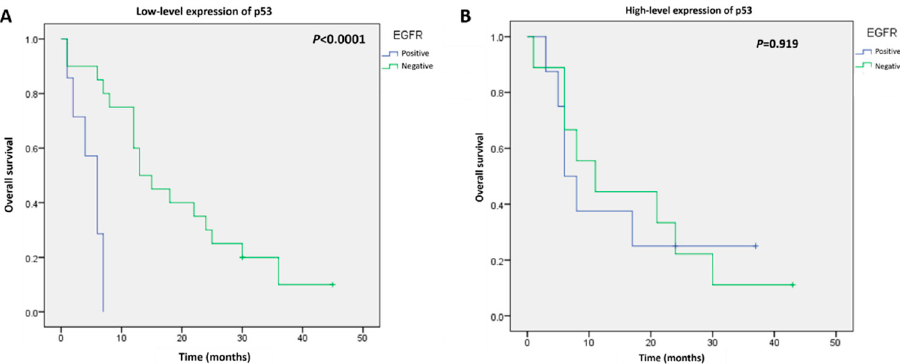
Figure 4. Kaplan–Meier analysis of overall survival in patients with EGFR-positive or EGFR-negative astrocytomas and ( A ) low-level expression of p53 or ( B ) high-level expression of p53. 3.4. Expression of p53, EGFR, and IC50s after Treatment with EGFR Inhibitors in GBM Cells Differences in p53 and EGFR protein expression in normal and cancer cells were deter- mined by Western blotting in glial cells (SVGp12) and GBM cells (GBM8041, GBM8901, U87-MG, G5T, and DBTRG-05MG). No significant differences in EGFR protein expression were detected in GBM8401, GBM8901, U87-MG, G5T, DBTRG-05MG, or SVGp12 cells (Figure 5). However, p53 protein levels were significantly lower in GBM8401, GBM8901, U87-MG, G5T, and DBTRG-05MG cells compared to the expression in SVGp12 cells (Fig- ure 5). In addition, p53 protein expression levels in GBM8401, GBM8901, and DBTRG- 05MG were significantly higher than expression levels in U87-MG and G5T cells (Figure 5). Therefore, GBM8401, GBM8901, and DBTRG-05MG cells had high p53 expression lev- els, and U87-MG and G5T cells had low levels of p53 expression.